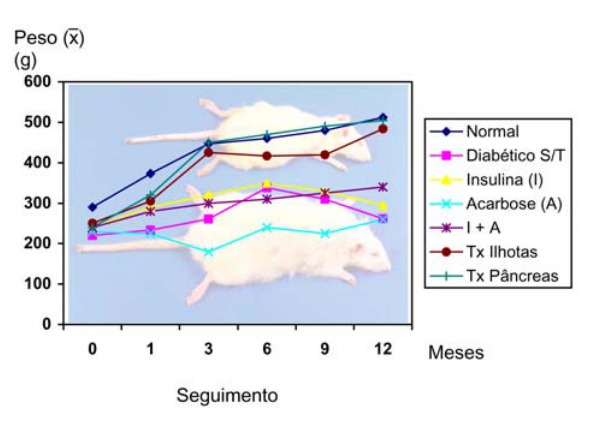
FIGURA 2 - Médias do peso corporal (g) de animais normais, diabéticos não tratados e diabéticos tratados com cinco diferentes tratamentos, durante 12 meses de